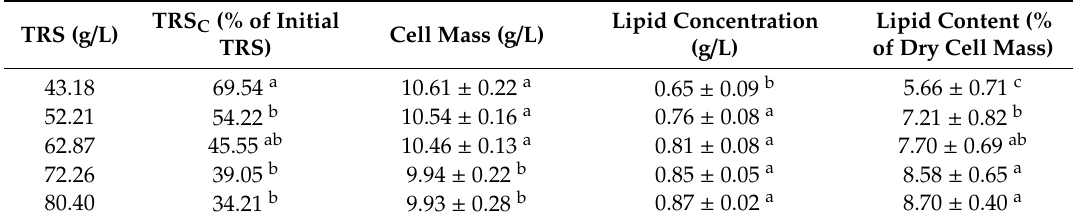
Table 3. Total reducing sugar consumption, cell mass, lipid concentration, and lipid content by R. fluvialis DMKU-SP314 at 48 h of first-stage